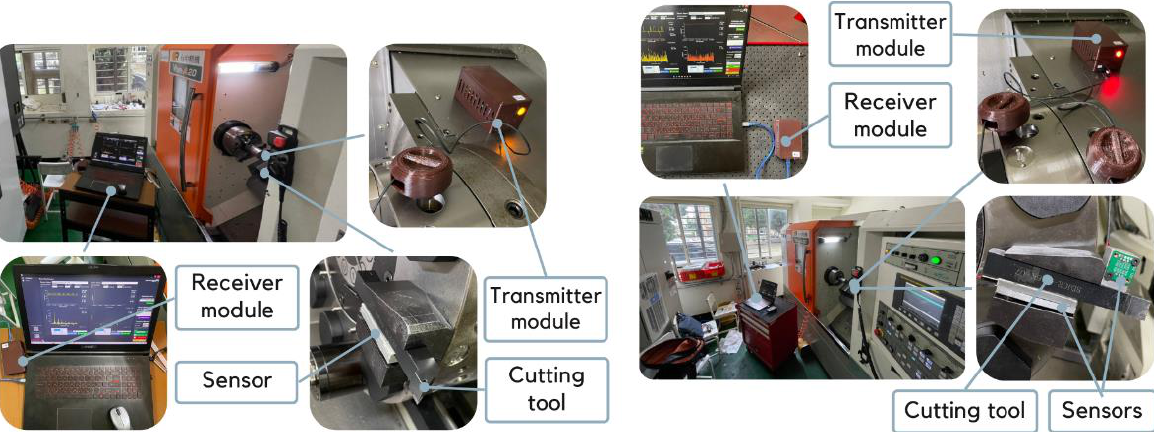
Figure 15. Monitoring arrangement of two machines.